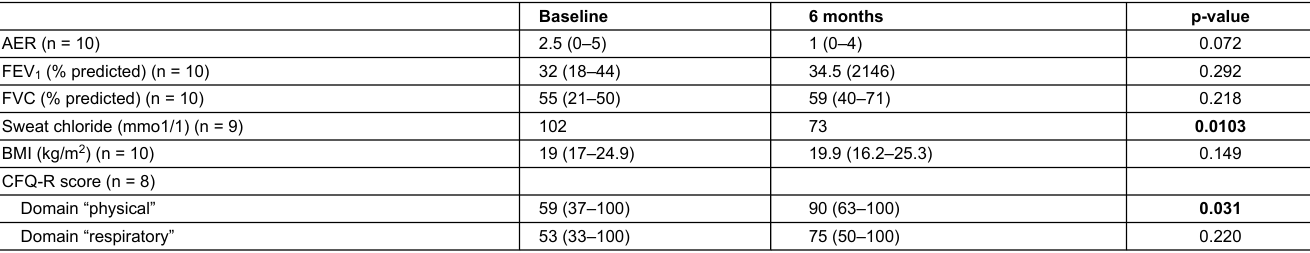
Table 2: Outcome parameters at baseline and after 6